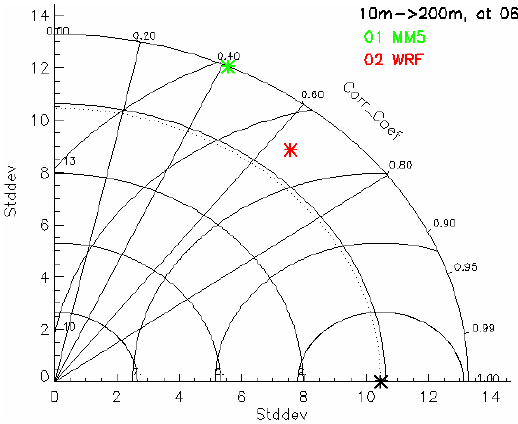
Fig. 3c. Statistics (Taylor plot, Taylor, 2001) for vertical potential temperature gradient profiles (10m–200m) by WRF, MM5 for the Linate airport, together with the observations for 06:00h for the whole